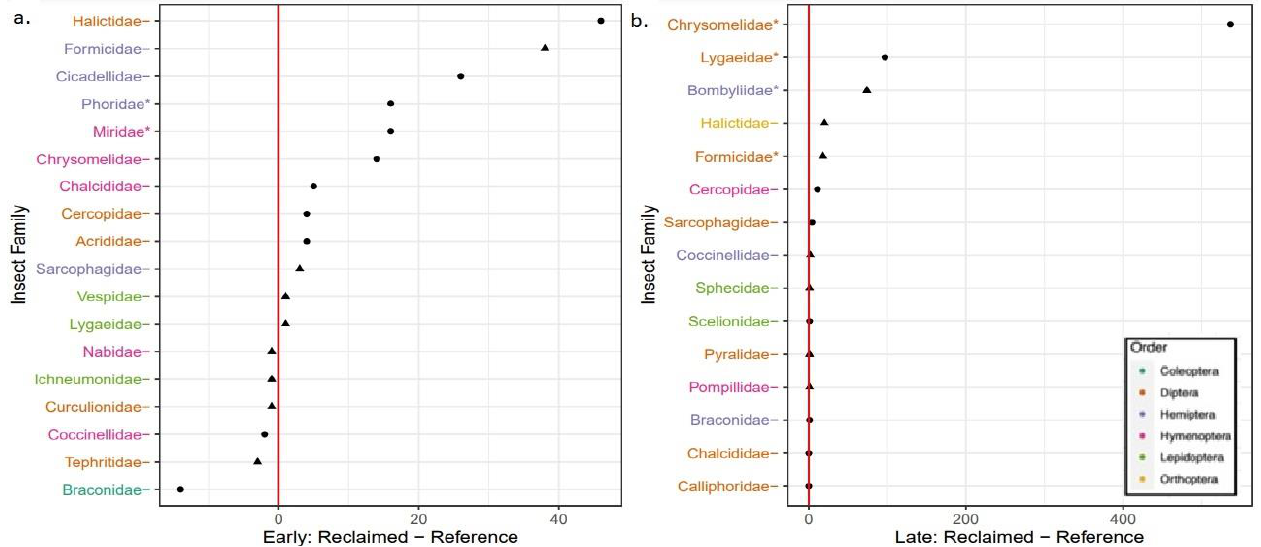
Figure 4. Total family level difference within each of 4 contrasts. ( a ) Reclaimed minus Reference within Early season. ( b ) Reclaimed minus Reference within late season. Triangular points represent families that were only found in one of the two conditions, whereas circular points represent families found in both conditions. Families with * next to them are those which had significant differences between site type with p < 0.05.